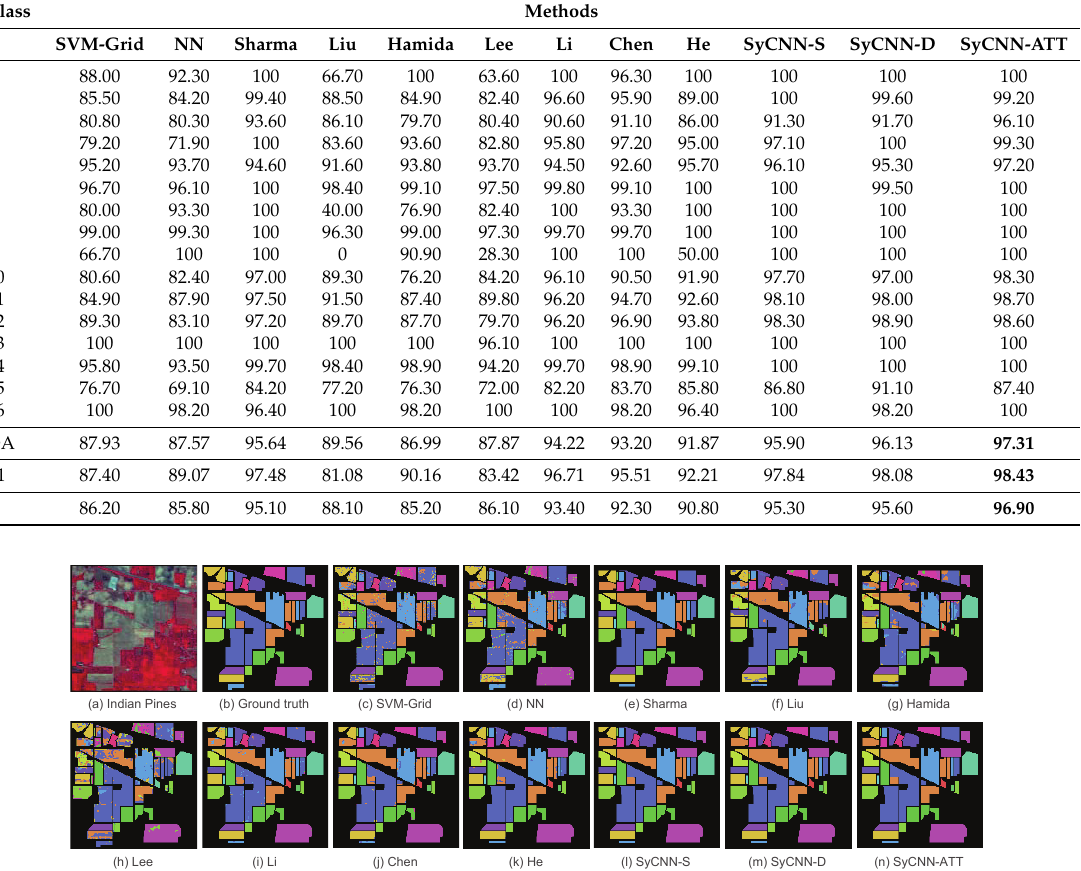
Table 4. Evaluation results on the Indian Pines Scene dataset. Class Methods